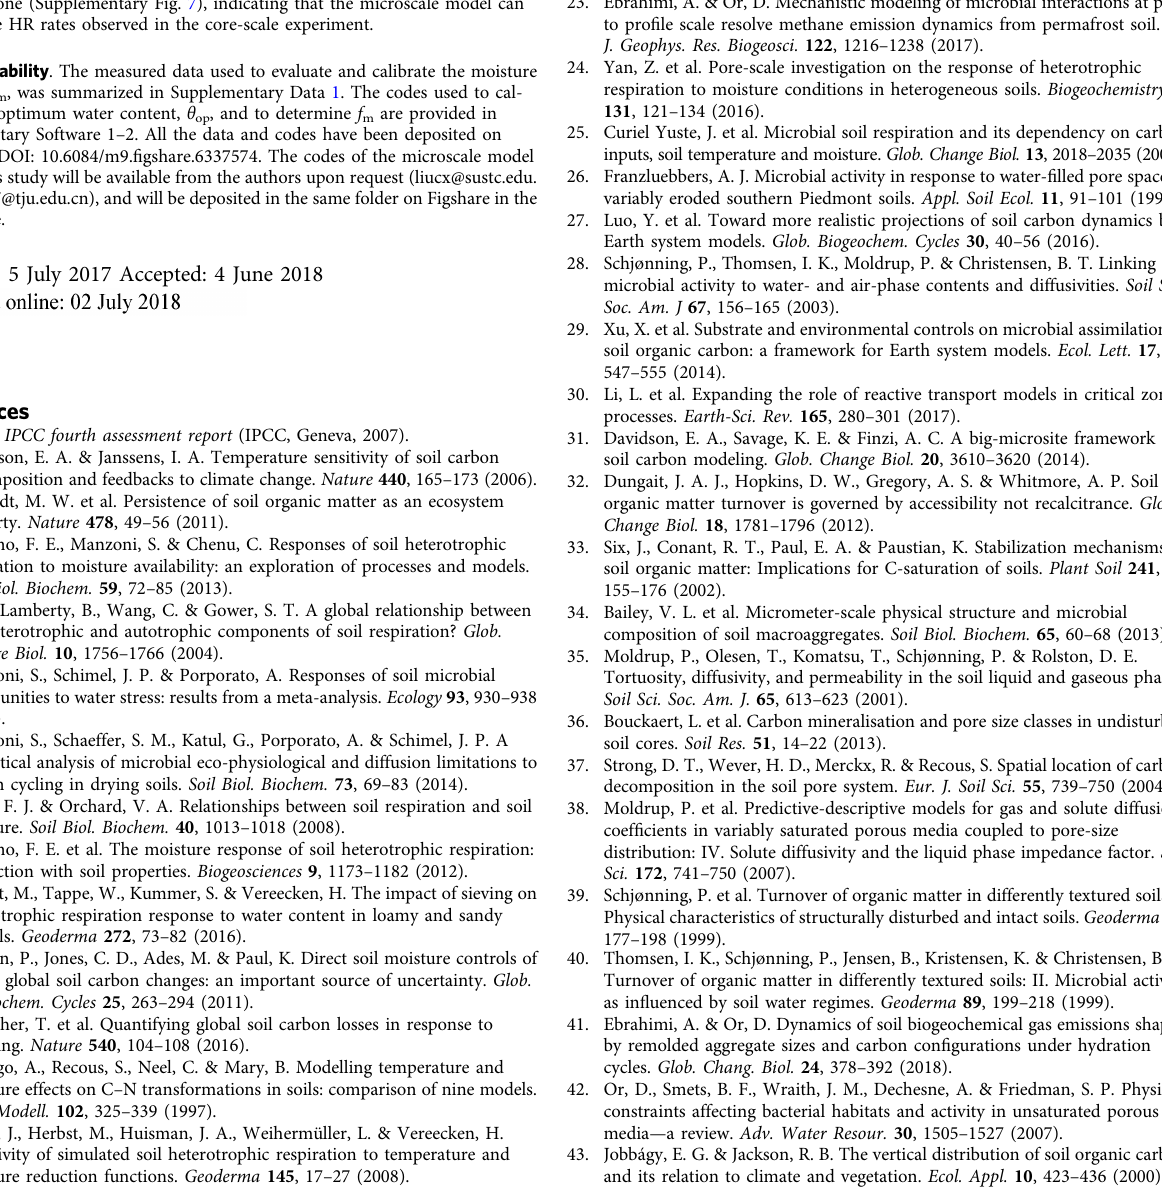
Figshare — DOI: 10.6084/m9. fi gshare.6337574. The codes of the microscale model used in this study will be available from the authors upon request